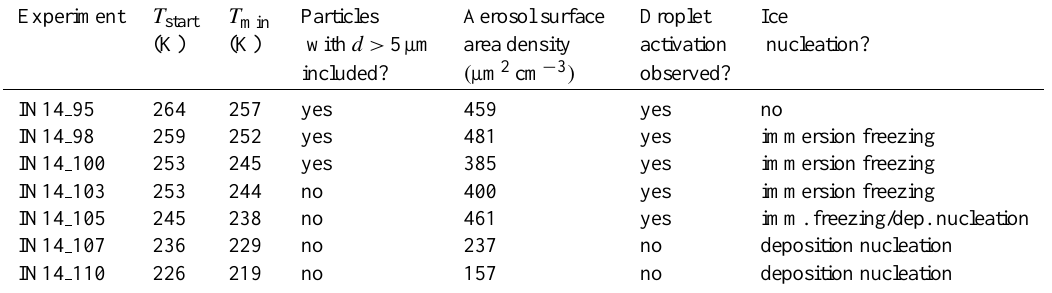
Table 1. Overview of ice nucleation experiments with EY01 as carried out at the AIDA cloud chamber; reference experiments being omitted Experiment T start T min Particles Aerosol surface Droplet Ice (K) with d > 5µm area density activation nucleation? included? observed? IN14 95